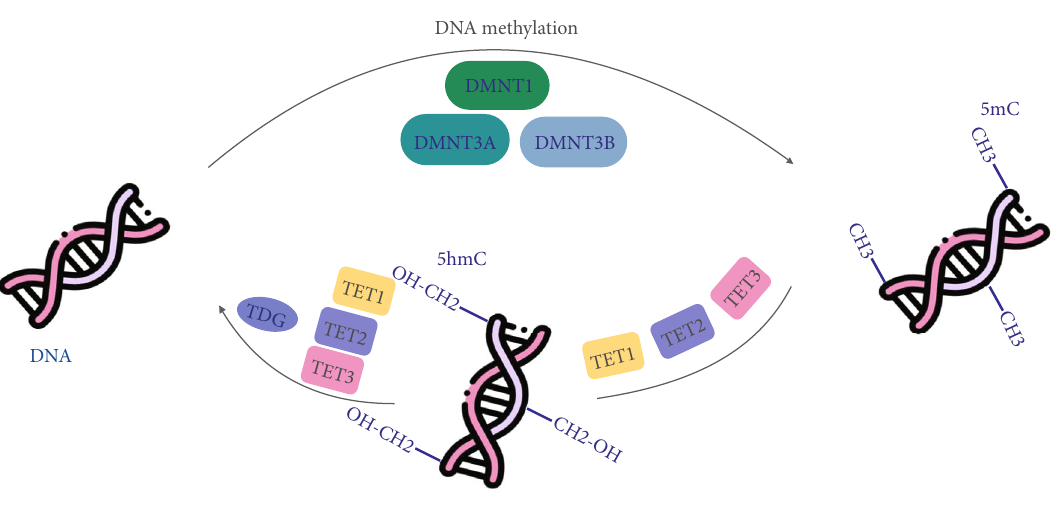
Figure 3: Schematic representation of DNA methylation patterning. DNA methylation is exerted by DNA methyltransferases (DNMTs), including DNMT1, DNMT3L, DNMT3B, and DNMT3A. DNMTs at the cytosine residue at the 5-position in CpG dinucleotides transfer methyl groups and generate 5-methylcytosine (5-mC). DNA demethylation involves the successive oxidation of 5-mC to 5- hydroxymethylcytosine (5-hmC) by Ten – eleven translocation (TET) family, including TET1, TET2, and TET3. Thymine DNA glycosylase (TDG) could convert 5-hmC back to make the cytosine totally unmethylated.